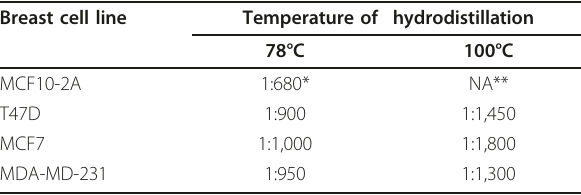
Table 2 IC50 values of Boswellia sacra essential oils on human breast cells Breast cell line